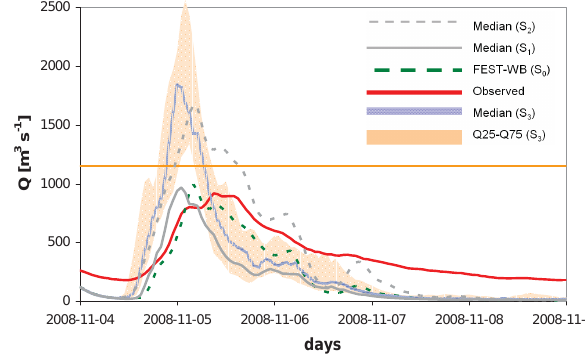
Fig. 7. QDF of the FEST-WB simulation ( S 2 ) forced with observed precipitation field and forecasted temperatures by the COSMO- LEPS model (blue line). The red line shows the observed discharge at Candoglia and the green dashed line shows the simulated dis- charge on the FEST-WB, forced with observed data ( S 0 ). The grey line illustrates the ensemble median of the simulation S 1 , as a com- parison with the new simulation ( S 2 ). The hydrological simulation was initialized on 4+November 2008. The horizontal orange line is warning code 2 for the Toce Basin.